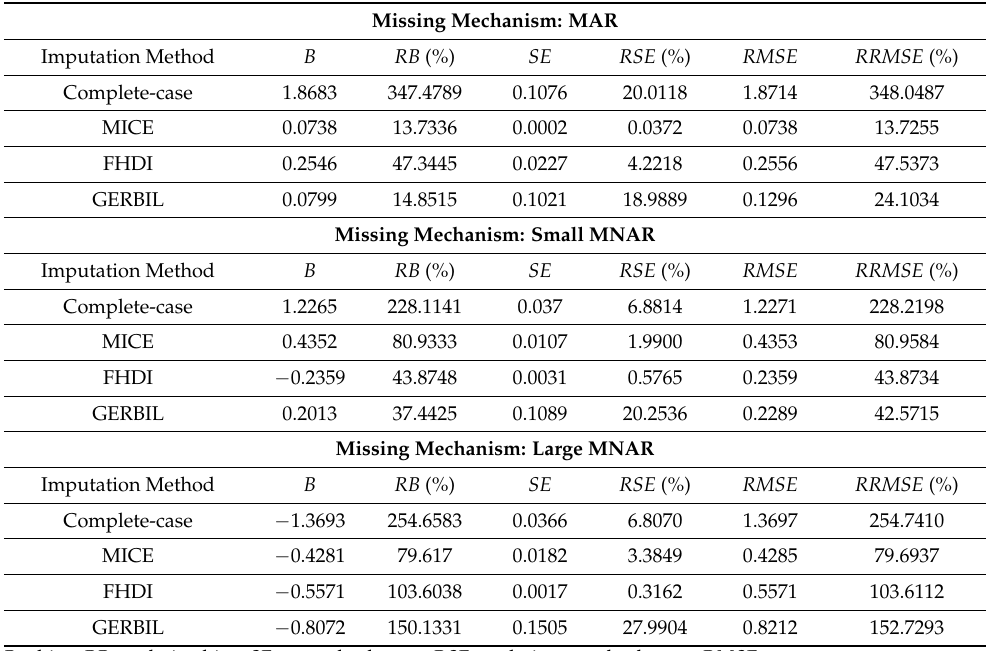
Table 6. Summary of Simulation Results for Regression Coefficient for NHANES Variable “Having High